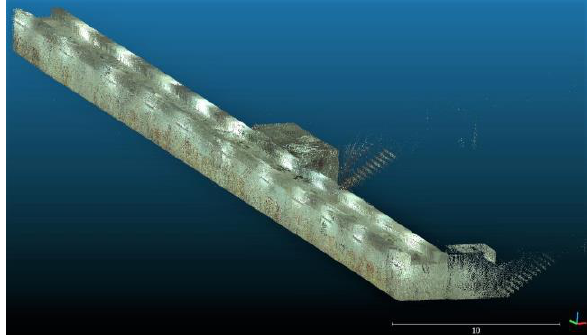
Figure 6. View of the point cloud acquired by the BLK2GO